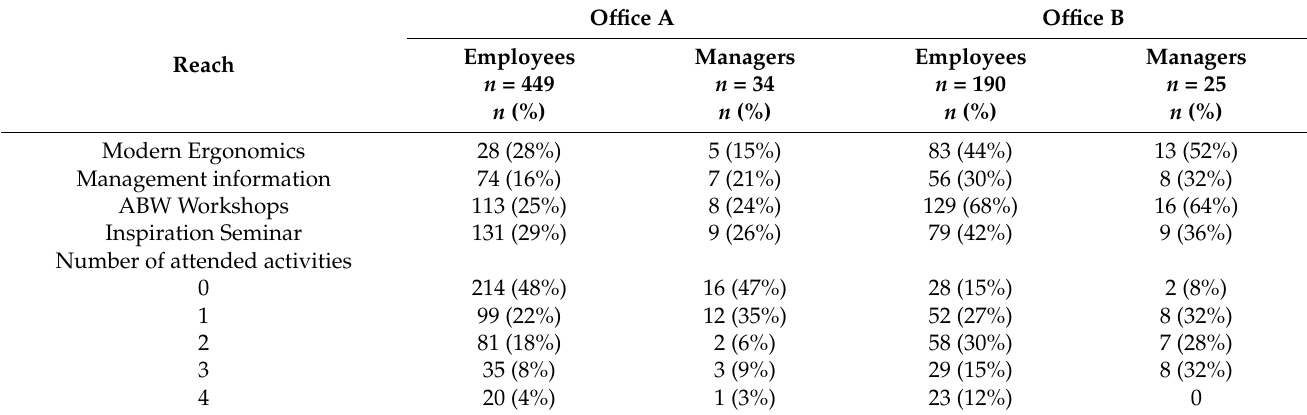
Table 3. The numbers and percentages of employees and managers who participated in program activities before the relocations of the two office